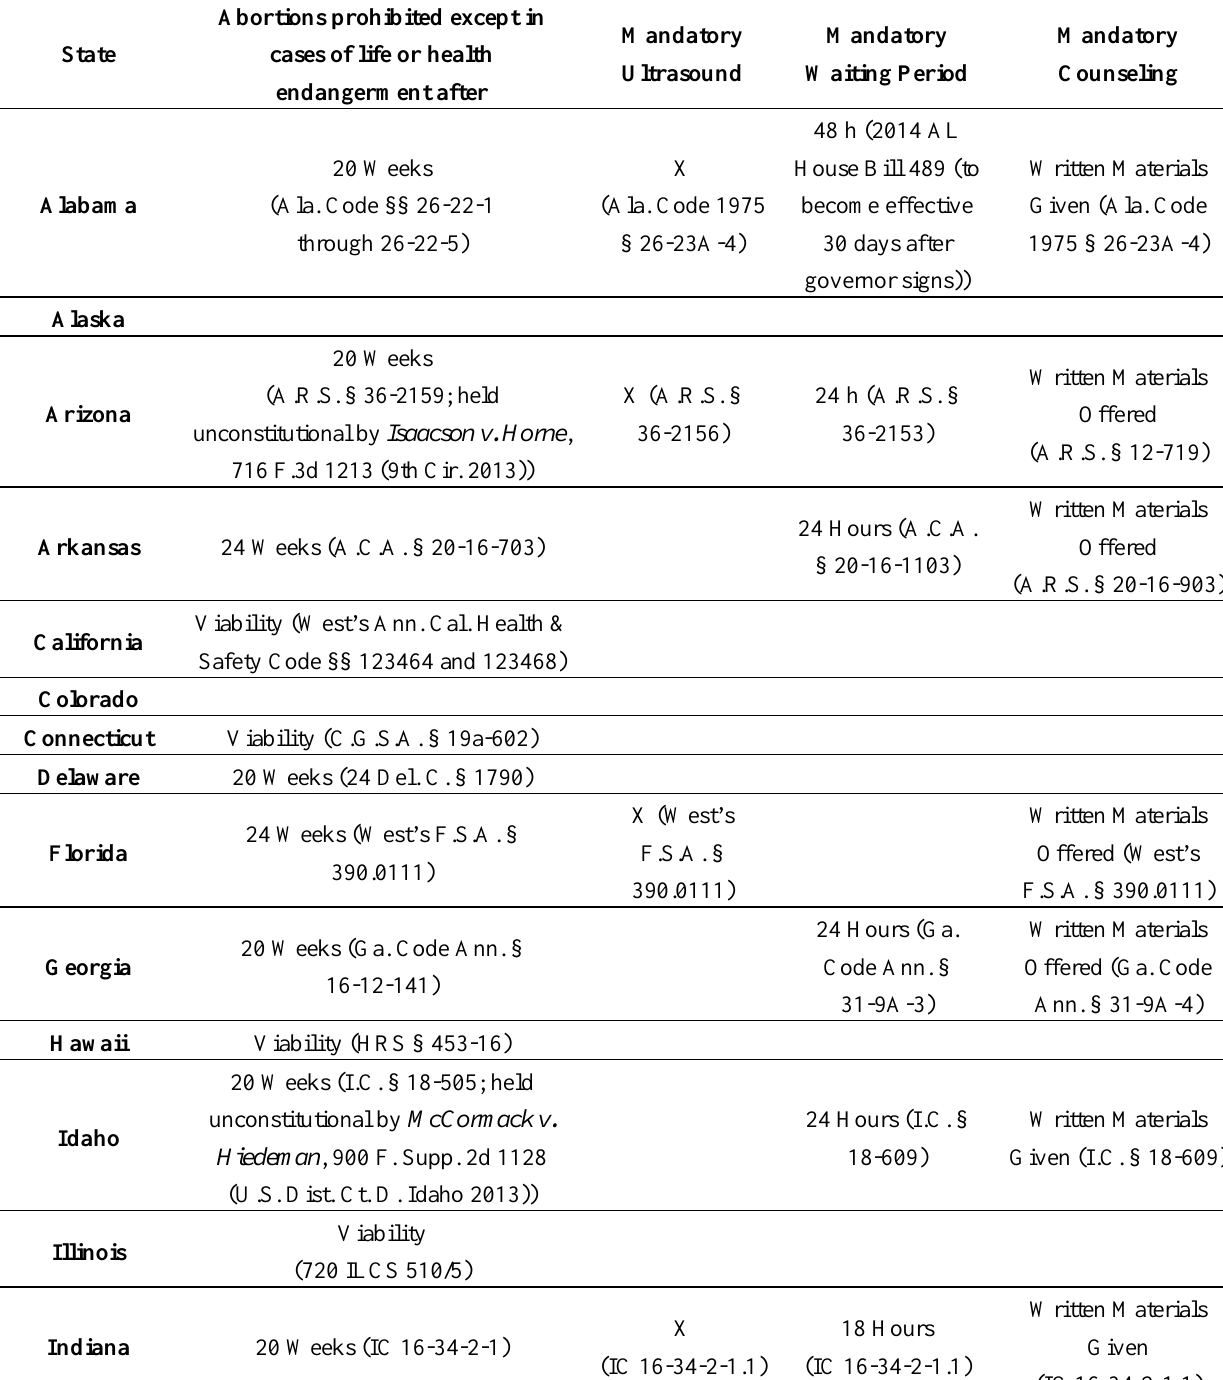
Table 2. State statutes regarding access to